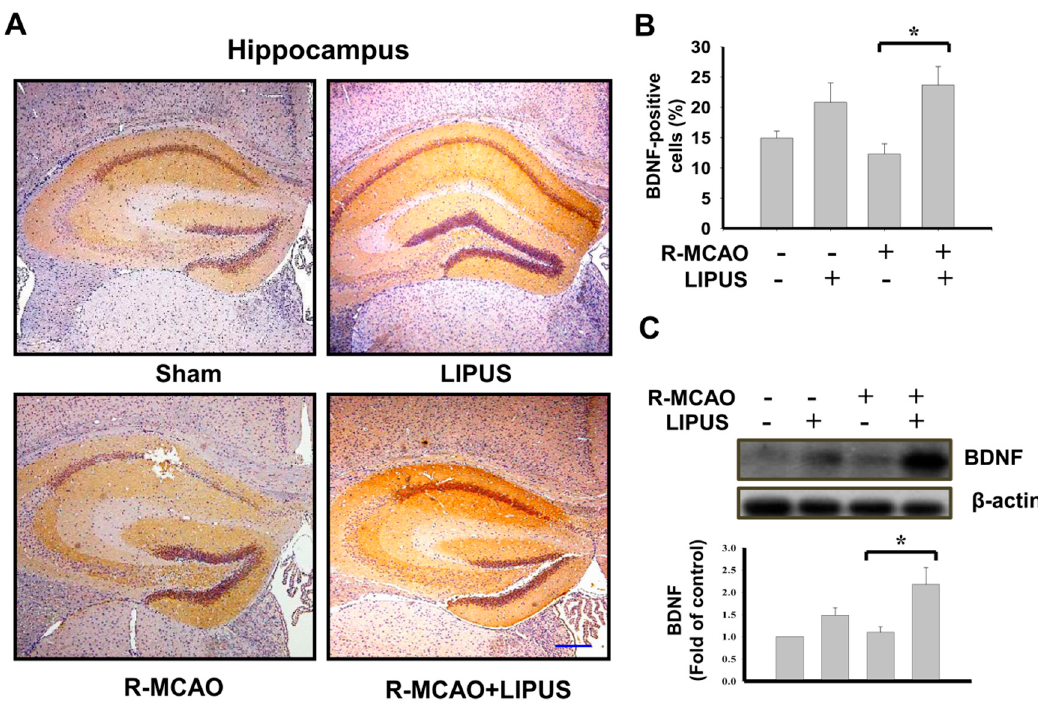
Figure 4. LIPUS treatment induced the protein expression of BDNF in the left cerebral hemisphere tissues of the recurrent stroke mice. Mice were treated with LIPUS 15 min daily for nine consecutive days before the secondary MCAO procedure. The protein expression of BDNF was determined by immunohistochemical staining (scale bar = 200 µ m) ( A , B ) and Western blotting ( C ). The quantification for BDNF-positive cells ( B ) or BDNF protein expression ( C ) was shown. The BDNF-positive cells in the hippocampal CA1 regions were counted. Data are presented as mean ± SD ( n = 6 per group). The ANOVA followed by the Bonferroni’s test was used for statistical analysis. * p < 0.05, versus R-MCAO group. L: LIPUS alone, R-MCAO: recurrent stroke model.